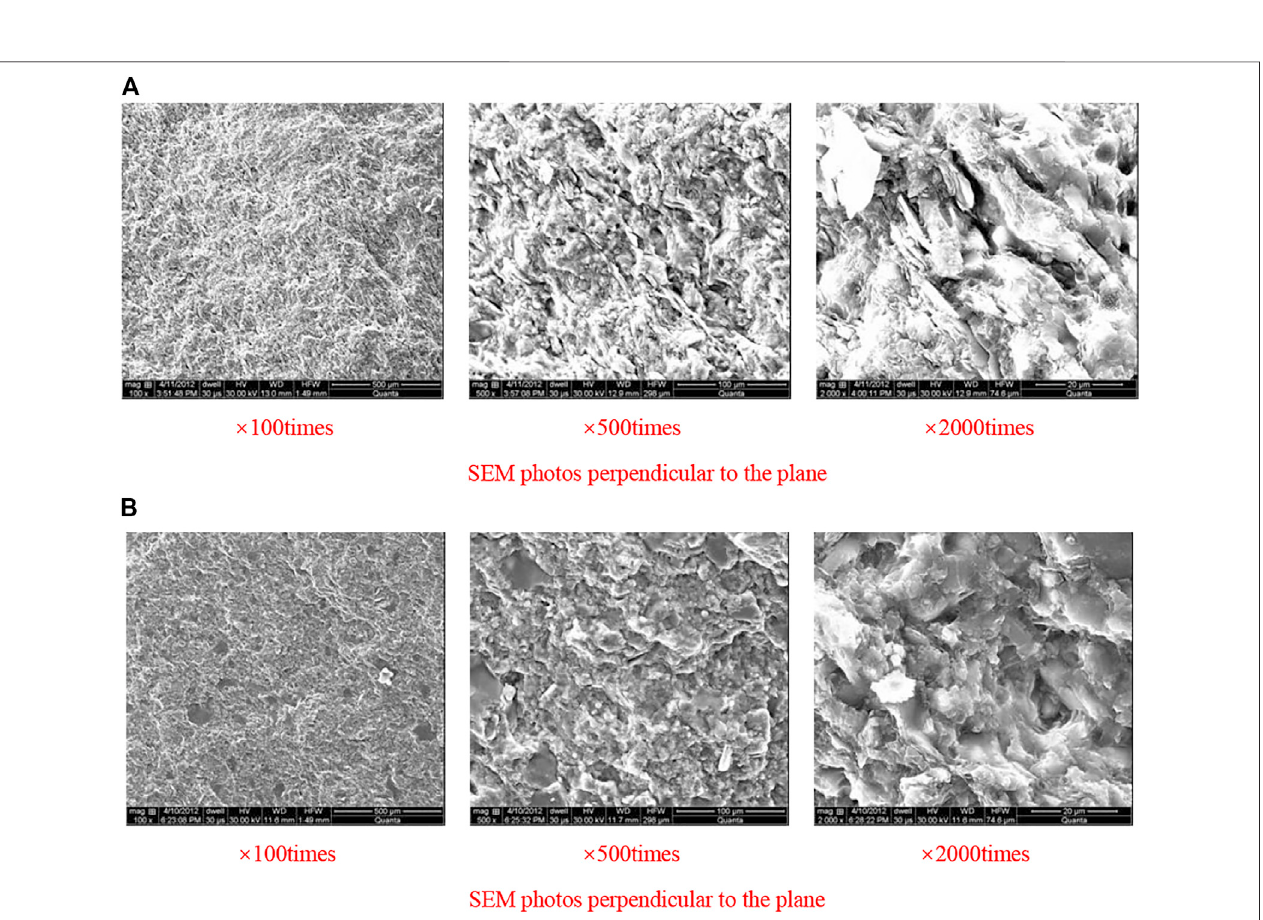
FIGURE 5 | SEM pictures for shale samples. (A) SEM photos perpendicular to the plane. (B) SEM photos perpendicular to the plane.